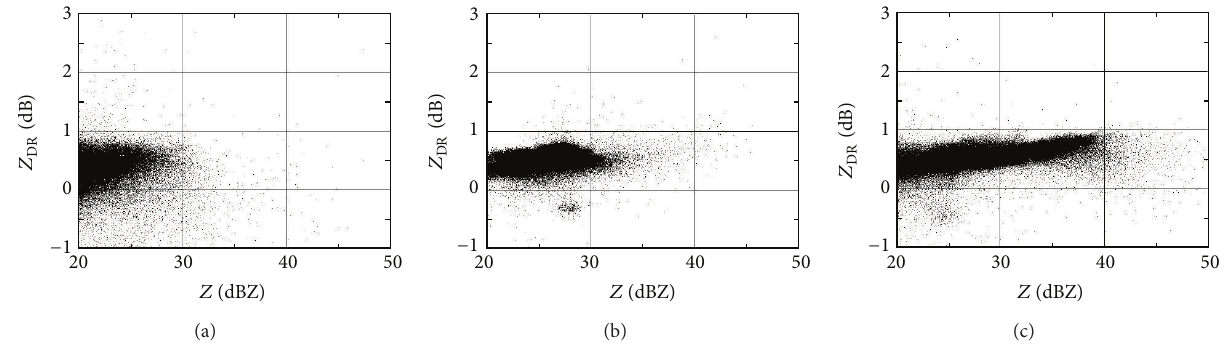
Figure 9: Scatterplots of average 𝑍 against 𝑍